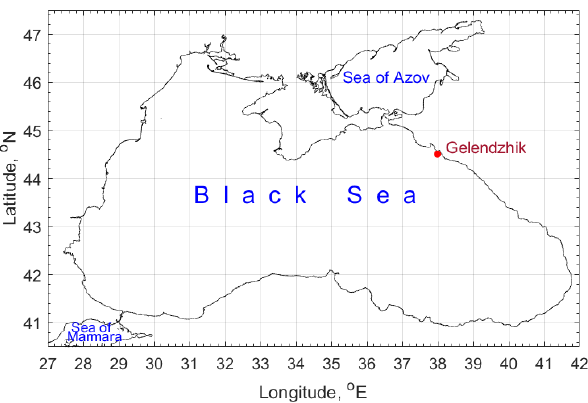
Figure 2. The Black Sea coastline (https://osmdata.openstreetmap. de/data/coastlines.html, last access: 19 July 2021). The observa- tional site off Gelendzhik is shown by a red dot. © OpenStreetMap contributors 2021. Distributed under the Open Data Commons Open Database License (ODbL)